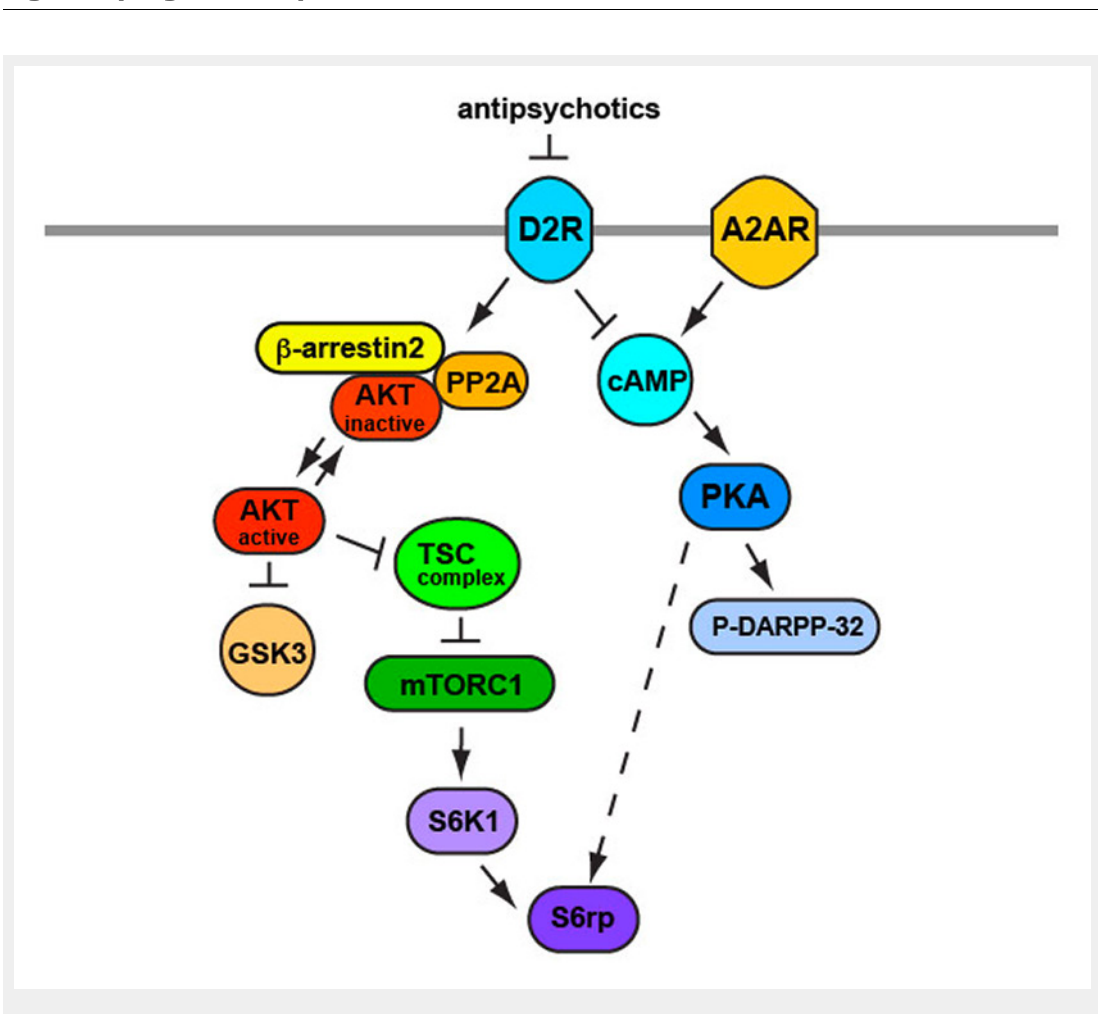
Figure 1 Schematic representing the action of antipsychotics on intracellular signaling cascade. Inhibition of D2Rs by antipsychotic results in increased cAMP levels produced by removing the tonic inhibition on adenylyl cyclase activity (see text for more details). This leads to activation of PKA and phosphorylation of DARPP-32. Moreover, antipsychotics, by antagonizing D2Rs, inhibit the activation of β-arrestin2/PP2A complex resulting in increased AKT activity. Both AKT and PKA lead to activation of mTORC1 and S6 ribosomal proteins, which regulated protein synthesis. AKT ≡ protein kinase B; cAMP = cyclic AMP; D2R = dopamine 2 receptor; DARPP-32 = dopamine- and cAMP-regulated phosphoprotein of molecular weight 32000; mTORC1 = mechanistic target of rapamycin complex 1; PKA = protein kinase A; PP2A = phosphatase 2A; S6K1 = p70 ribosomal S6 kinase 1; S6rp = S6 ribosomal protein; TSC = tuberous sclerosis